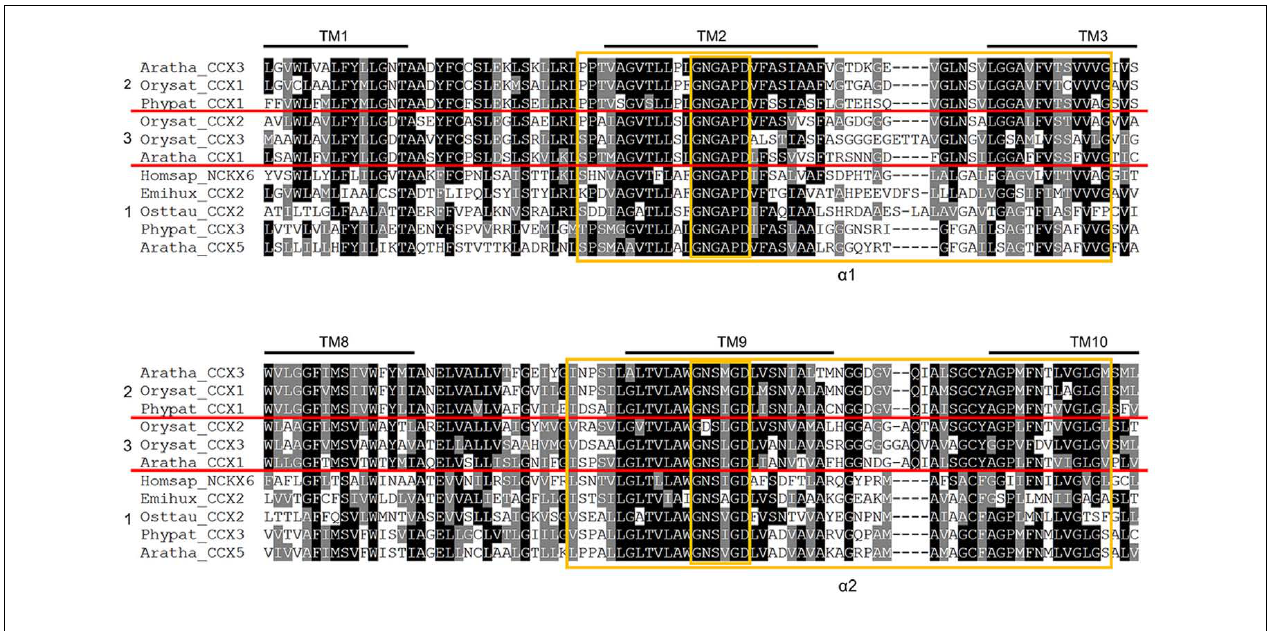
similar are shaded black or gray, respectively. Predicted transmembrane spans are over-lined.The α -repeat regions and signature residues are boxed in yellow.The red lines separate the Group 1, 2, and 3 CCX